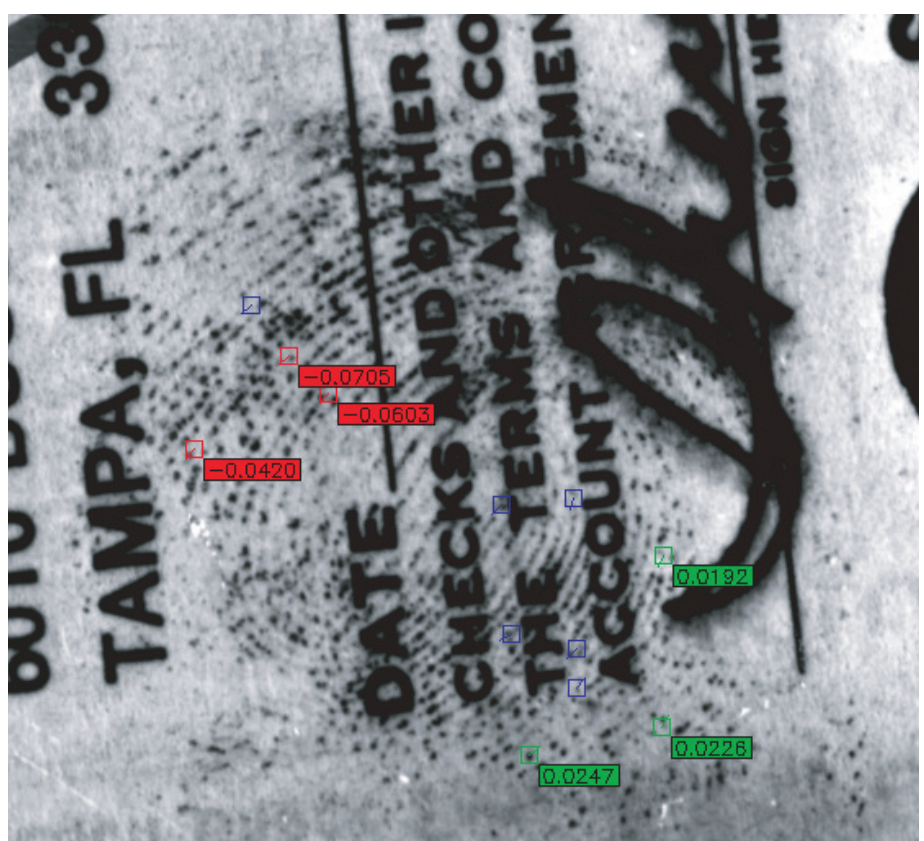
Figure 8. Example of a latent fingerprint taken from NIST SD27 [23]. Minutiae labeled as “higher” class are in green color, those labeled as “lower” class are in red color, and the remaining minutiae are in blue color. In both “higher” and “lower” classes, the minutiae contain the score difference that they introduce to the final score when that particular minutia is removed.